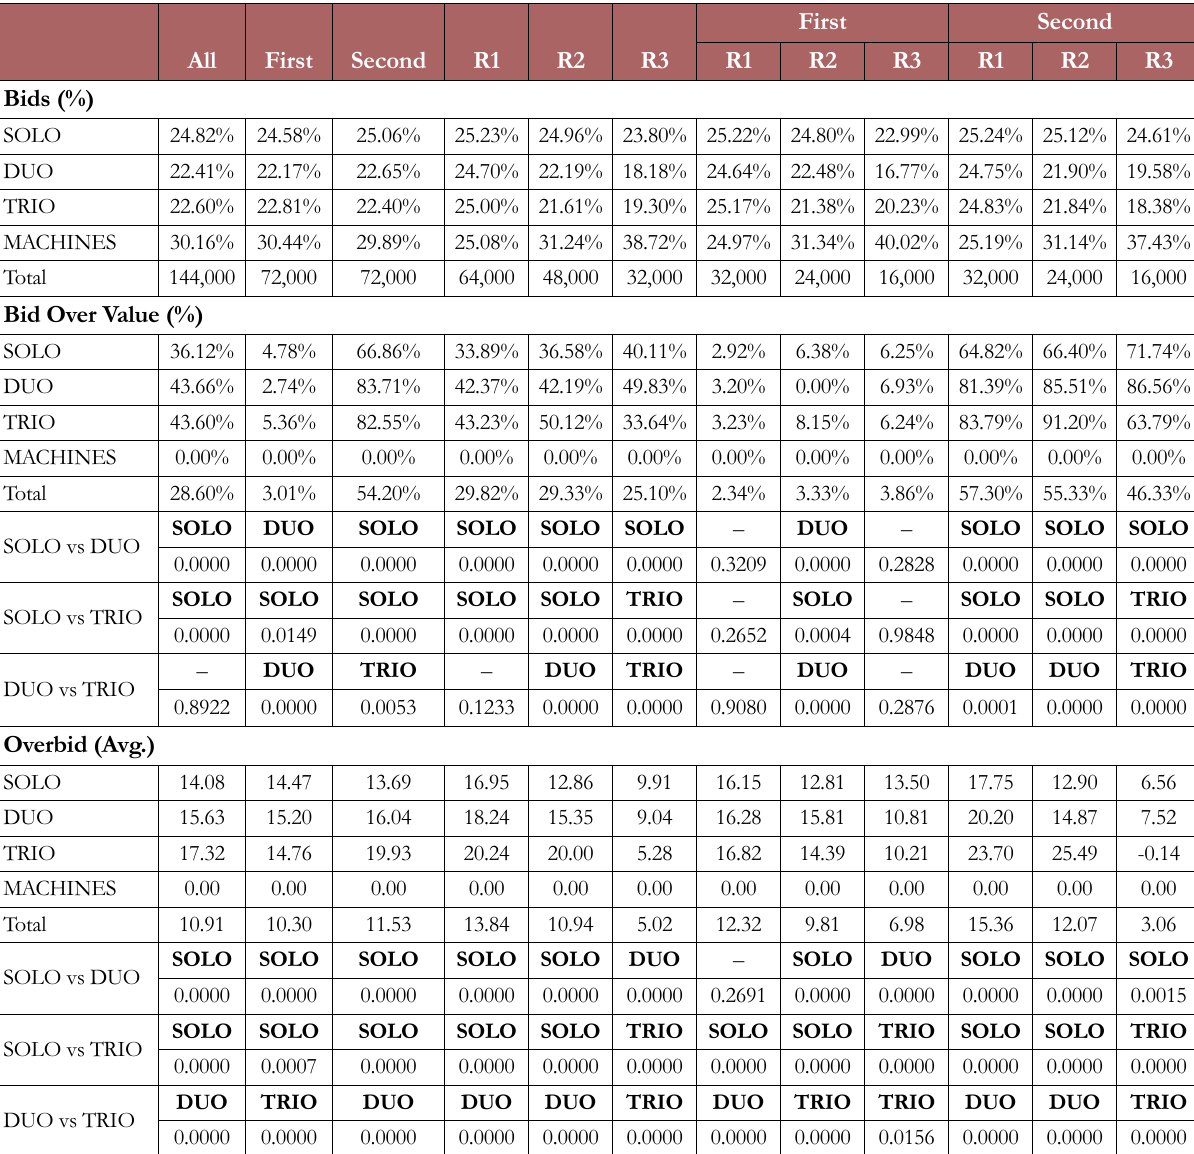
Table A2.5. Influence of machines and bidding: pairwise differences in terms of size by right and